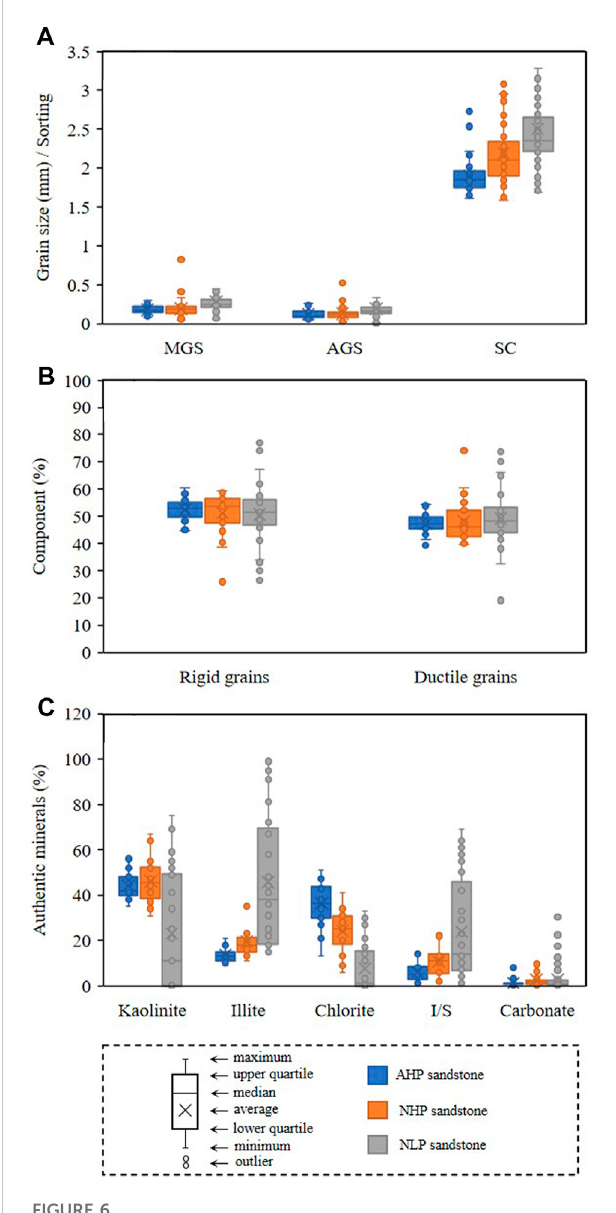
FIGURE 6 Boxplotsofthedetritalgrainsizeandsortingcoef fi cient (A) ,detrital component (B) , and authigenic minerals (C) in the J 2 x 1+2 sandstones in the Taibei Sag. MGZ-medium grain size; AGZ- Average grain size; SC- Sorting coef fi cient; I/S- illite/smectite mixed